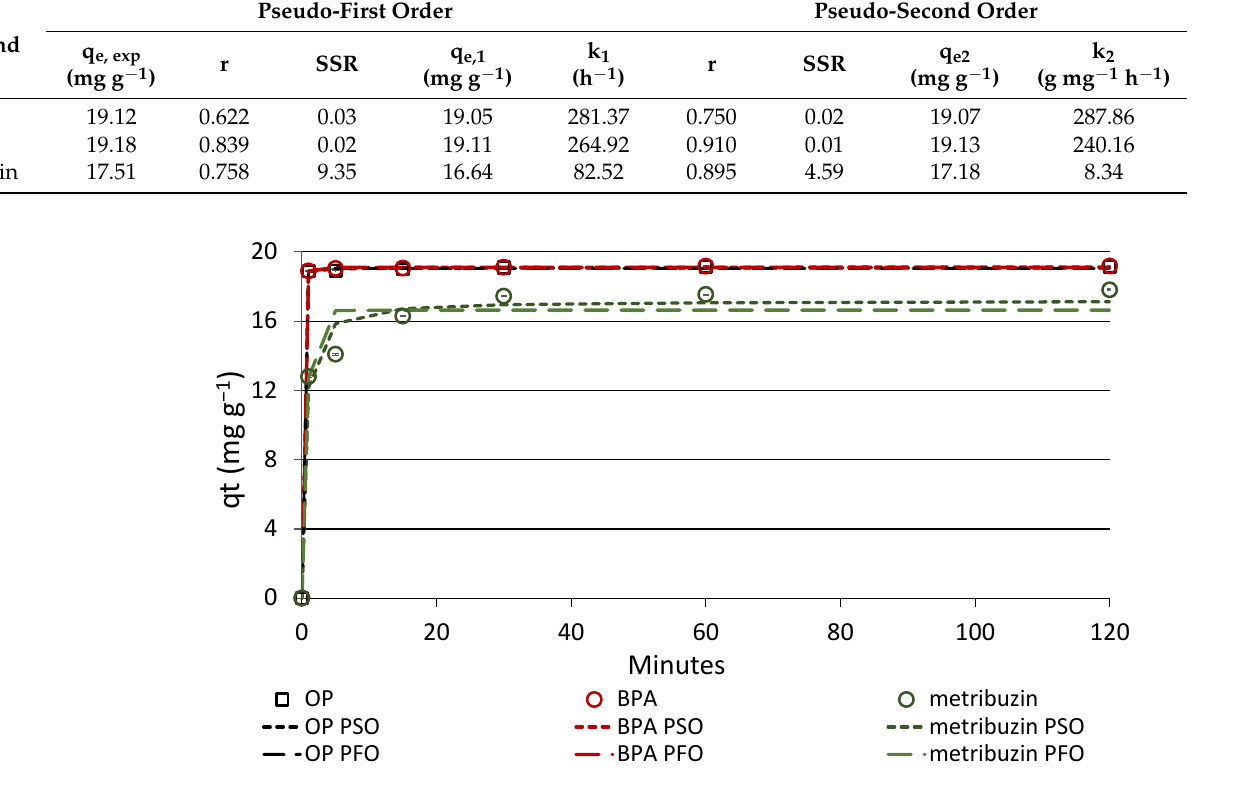
Table 4. Kinetic pseudo-first order and pseudo-second order parameters obtained through the non-linear regression for the adsorption of the compounds onto the biochar. Pseudo-First Order Pseudo-Second Order Compound